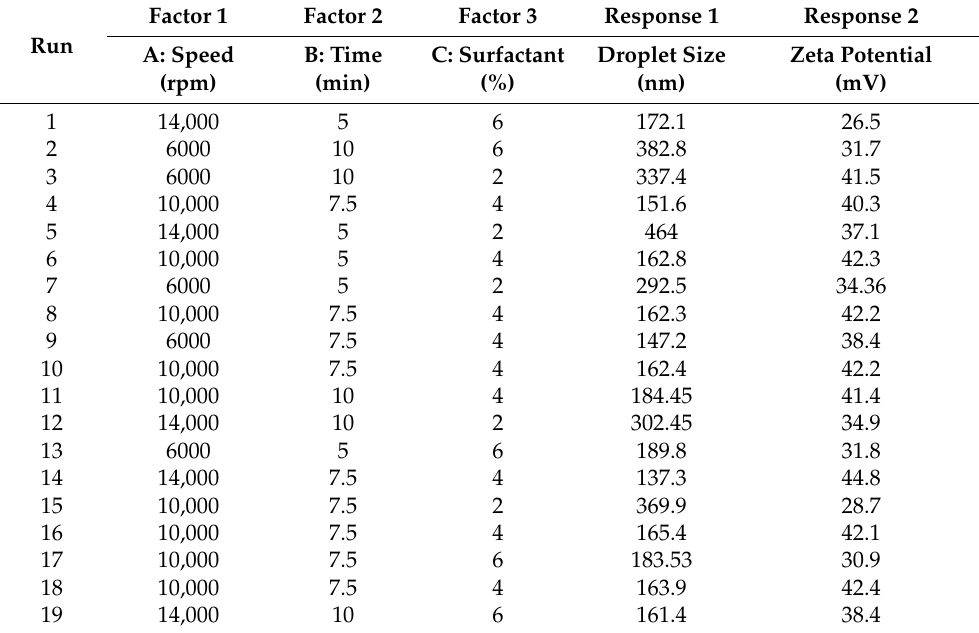
Table 2. Central composite design runs and their observed